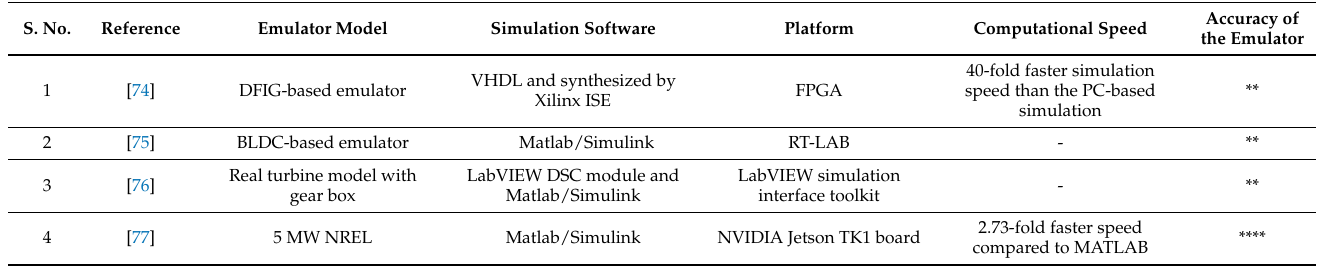
Table 3. Comparison of computational